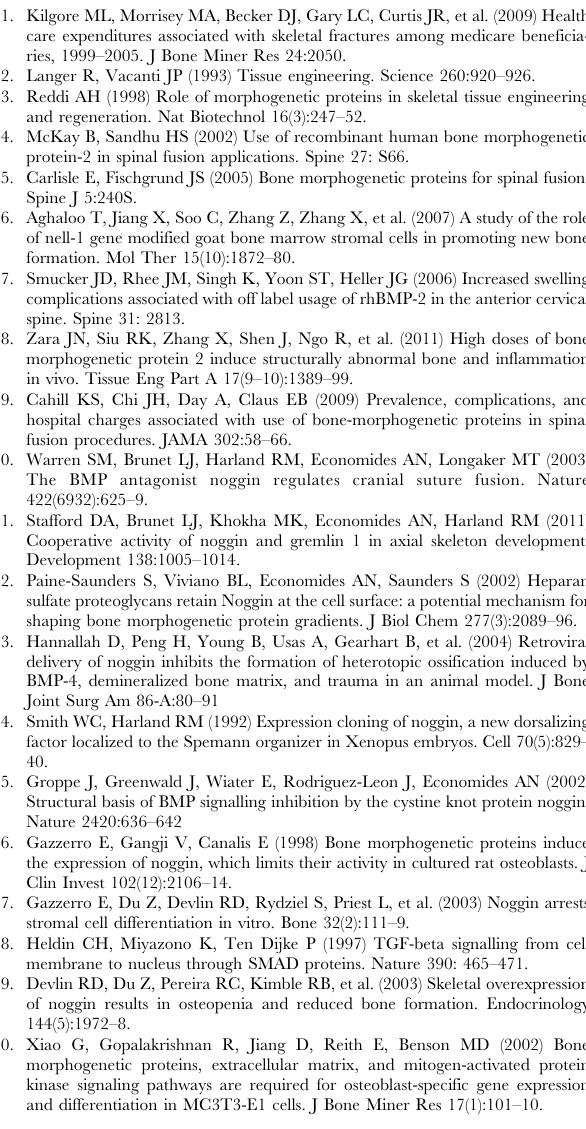
Figure S1 ASCs proliferation and differentiation ability. (A) Colony formation assay. ASCs were stained with crystal violet. (B) Multilineage differentiation potential. Chondro-, osteo- and adipogenic differentiation of ASCs were detected with Safranin-O (B1), Alizarin red (B2), and Oil red (B3) staining. Scale bar = 200 m m. (TIF) Figure S2 Transduction efficiency in ASCs by lentiviral particles. ASCs were treated with GFP-expressing lentiviral particles and observed under fluorescent microscope. Scale bar = 100 m m.